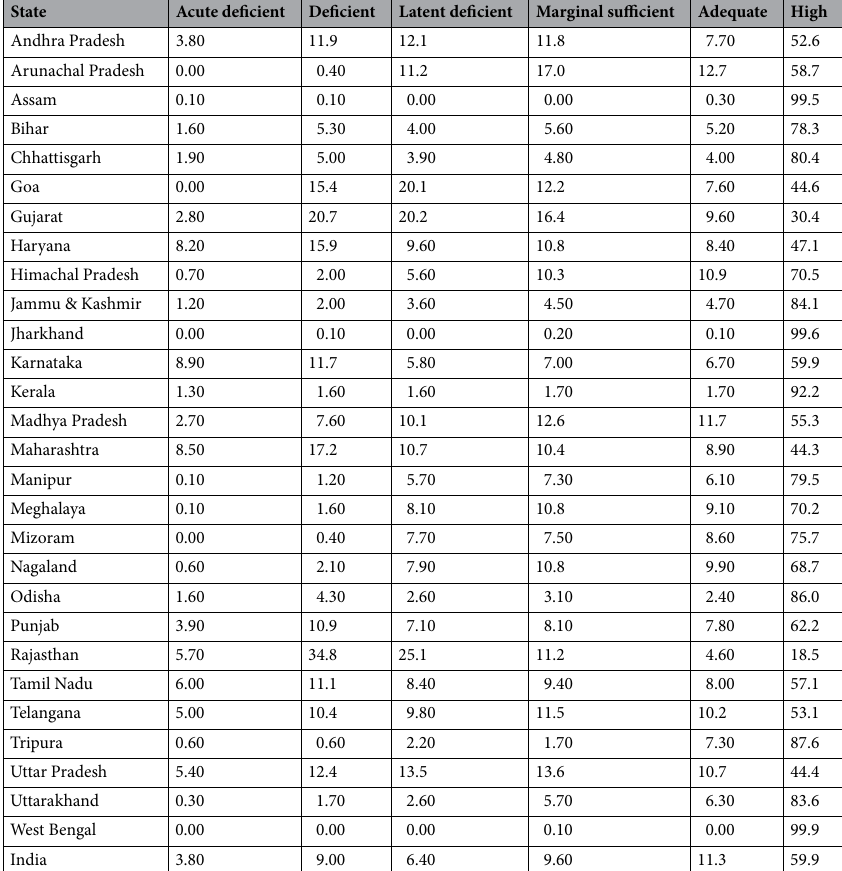
Table 5. State-wise deficiency (% of soil samples) status of available